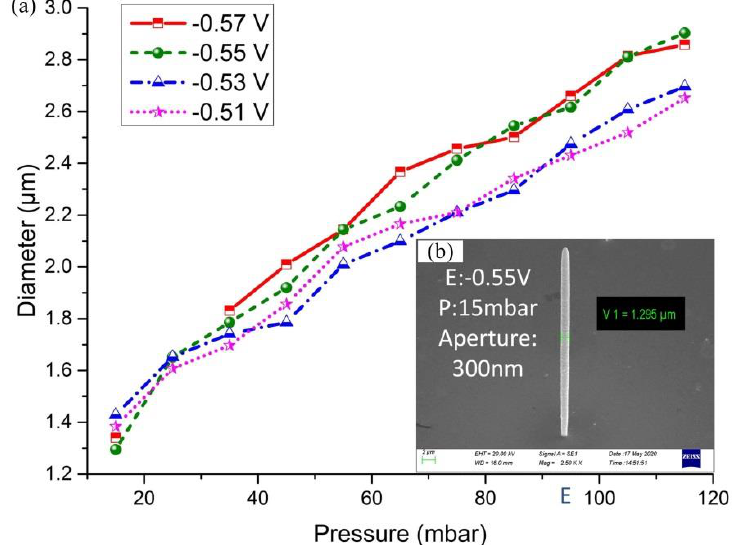
Figure 8. The diameters of the cylinder deposit with different pressures and voltages. ( a ) The graph of the data of diameter with different pressures. The diameter is measured by SEM picture. ( b ) The measurement line is marked on the deposit. Additionally, the diameter measured positioned on the half height of the cylinder deposit.